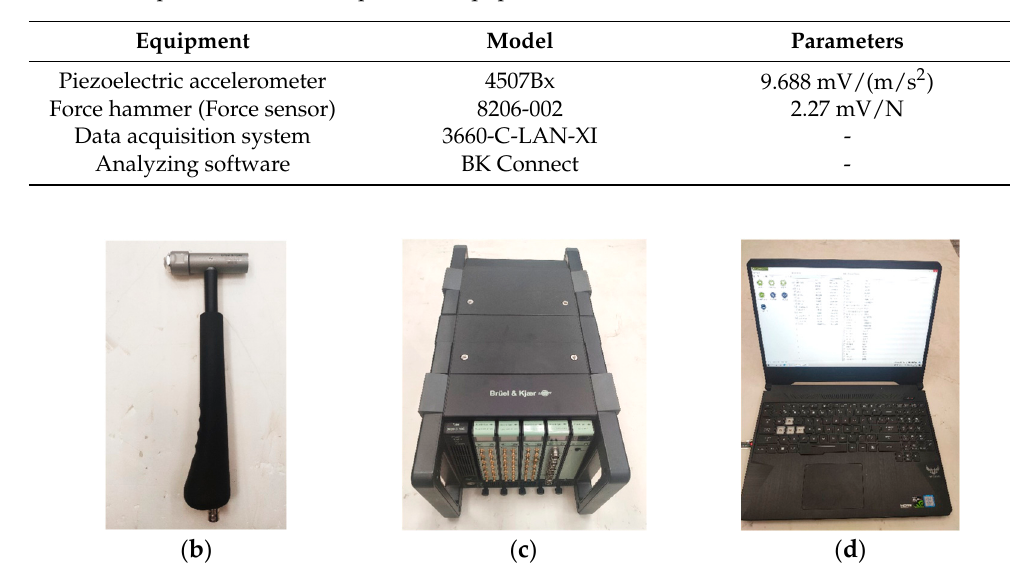
Figure 5. Hammer experiment bench installation diagram. Table 2. The parameters of the experiment equipment.